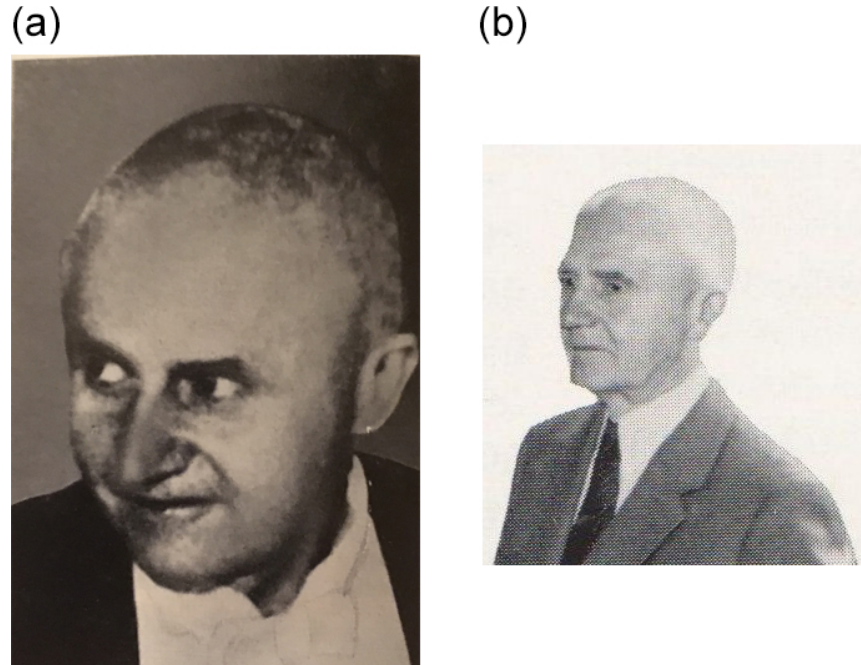
Figure 1. (a) Karl Friedrich Almstedt, around 1957 (from Bödecker, 1965, p. 78). (b) Karl Friedrich Almstedt, around 1964. This photo is reproduced from a brochure published on the occasion of the official opening of the new school building of the Ricarda-Huch-Schule in Braunschweig 1964; with the permission of Friedrike